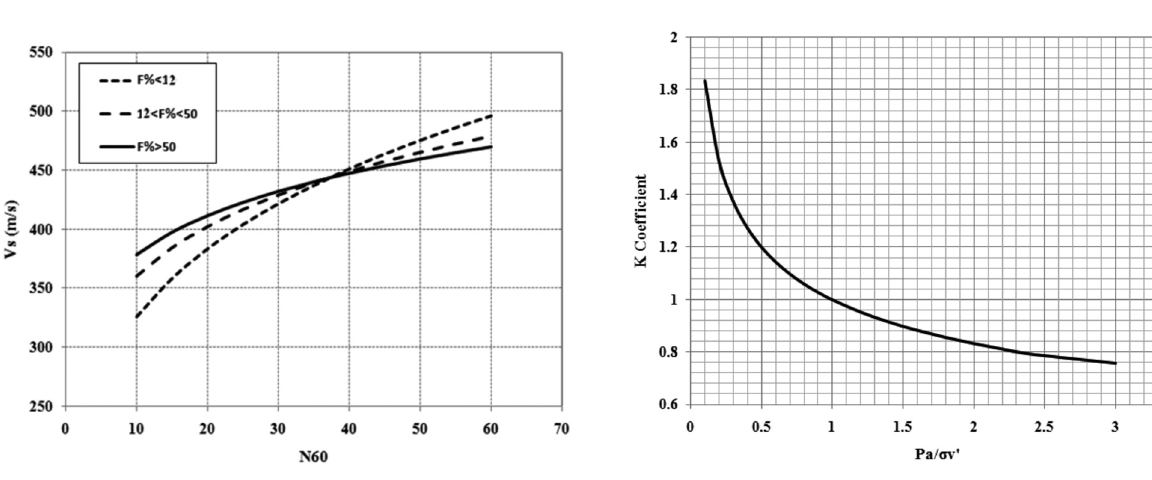
Table 3. Regression models and adjusted R 2 for all groups that are divided based on fine percent, LnV ) natural logarithm of N-SPT corrected for energy, velocity, Ln ( N 60